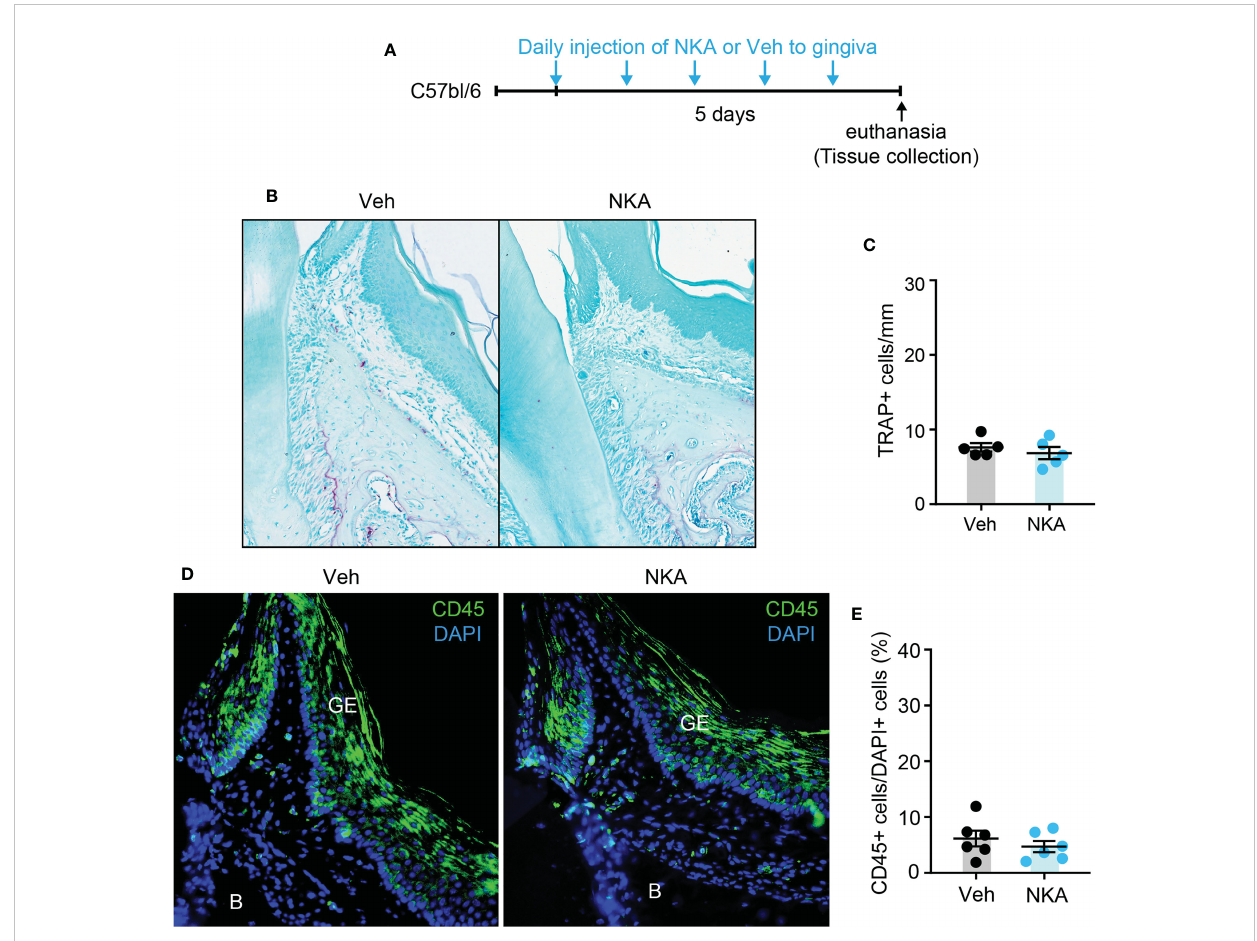
FIGURE 8 Exogenous injection of neurokinin A is not suf fi cient to activate osteoclasts and to recruit immune cells in periodontium. (A) Time course of the experiment. (B) TRAP staining in neurokinin A (NKA; 1 µg/site)- or vehicle (Veh) injected into a periodontium. Scale bar, 100 µm. (C) Quanti fi cation of TRAP+ cells of the injected periodontia. N=6 mice per group. P>0.4 in Student ’ s t-test. N=6 mice per group. (D) Immuno fl uorescence for CD45 in periodontia injected with Veh or NKA. Scale bar, 100µm. B, bone; GE, gingival epithelium. (E) Quanti fi cation of CD45+ cells. Percentage of the number of CD45+ cells among DAPI+ cells in gingival epithelium and connective tissues within 600 µm distance to tooth surface was calculated. P>0.7 in Student ’ s t-test. N=5 mice per